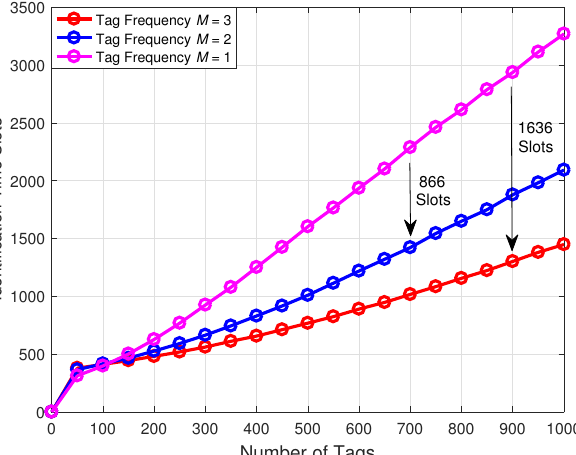
Figure 8. Comparison of the identification time slots with respect to the number of tags under the different number of frequencies.